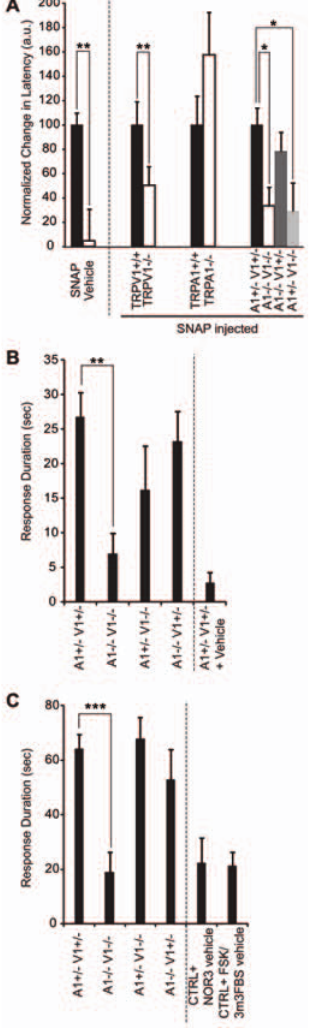
Figure 6. NO donors induce TRPV1-dependent thermal hyper- algesia and nocifensive behavior upon sensitization via TRPV1 and TRPA1. (A) Normalized changes in paw withdrawal latency are shown in response to a heat stimulus (average of three stimuli) 30 min after SNAP injection (25 mM in PBS, 1% DMSO). Decreases in paw withdrawal latency (%) were normalized to the value of SNAP-injected control mice (left columns) for each grouping (the larger the percentage, the faster the withdrawl to a heat stimulus). The first grouping represents SNAP- or vehicle- (1% DMSO) injected C57BL6 mice. The next three groupings show SNAP-induced thermal hyperal- gesia in littermates with genotypes shown at bottom. Latencies of control animals were similar; 2.9 6 0.4 (SNAP-injected C57BL6), 2.7 6 0.3 (TRPV1 + / + ), 3.5 6 1.0 (TRPA1 + / + ), 3.4 6 0.6 (A1 + / 2 V1 + / 2 ). (B, C) Nocifensive response duration (flicking, licking, and lifting injected paw) recorded over 10 min after injection of NO donors in the hindpaw. N $ 10 mice were tested (N $ 6 for vehicle controls). Mice were first injected with forskolin and m-3M3FBS (1 mM each) followed by NOC7 (25 mM) (B) or NOR3 (1.5 mM) (C) injection. Genotype of animals is indicated (A1: TRPA1, V1: TRPV1). Vehicle-injected control mice ((B): A1 + / 2 V1 + / 2 + vehicle: vehicle injection 5 min after first injection, (C):CTRL + NOR3 vehicle: vehicle injection 15 min after first injection, and CTRL + FSK/ 3M3FBS vehicle: first injected with vehicle for forskolin and m-3M3FBS followed by NOR3 injection 15 min after first injection) are also shown. CTRL mice in (C) share the same genetic background and carry at least one copy of wildtype TRPV1 and TRPA1; the first four columns represent results from littermates.